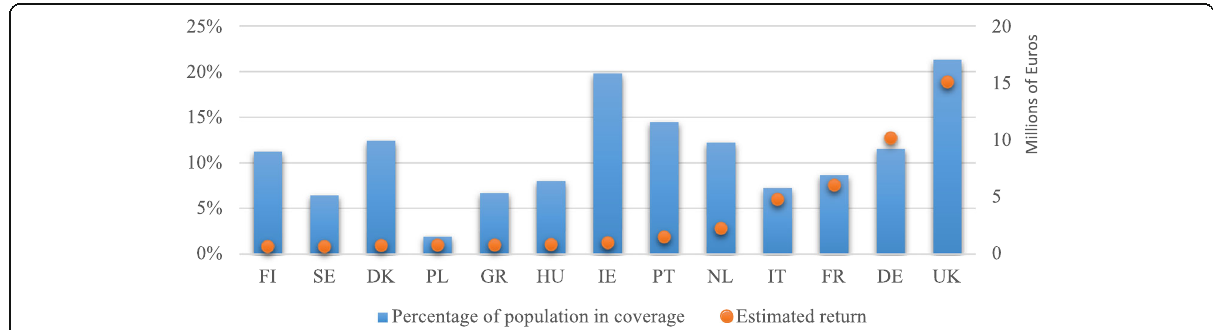
Fig. 11 Percentage of population covered by drone service (left axis) and estimated return of drone delivery hives per country (right axis) for Scenario 1 and a 650,000-euro economic viability